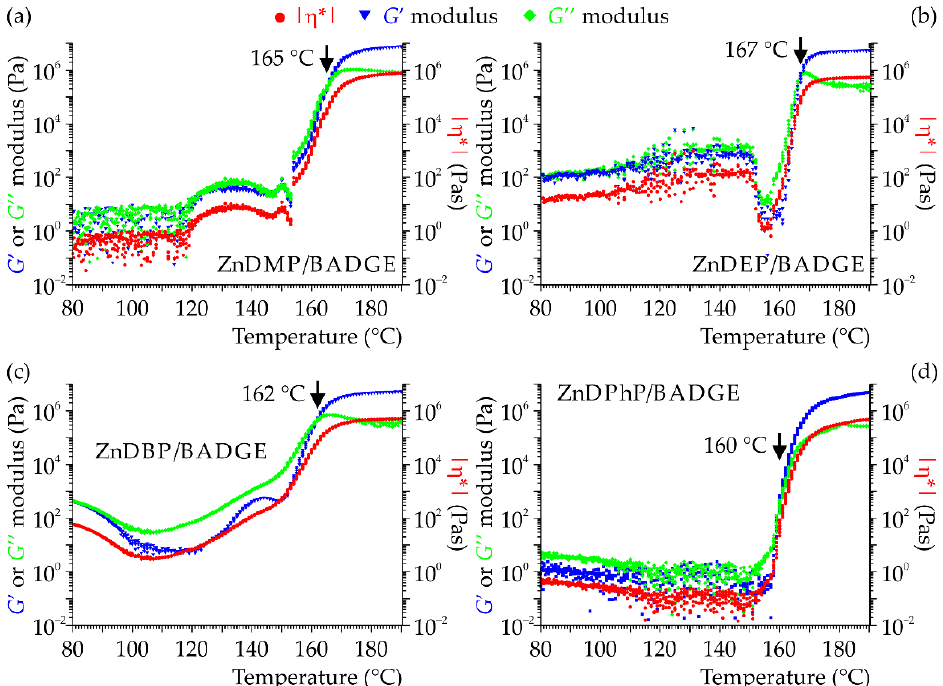
Figure 7. Variation of the complex viscosity (| η *|), storage modulus ( G ’) and loss modulus ( G ’’) with temperature during thermal curing of the ZnDOP/BADGE mixtures containing 20 wt%: ( a ) ZnDMP (ZnDMP/BADGE), ( b ) ZnDEP (ZnDEP/BADGE), ( c ) ZnDBP (ZnDBP/BADGE), or ( d ) ZnDPhP (ZnDPhP/BADGE). The lowest temperature at which G (cid:48) ≥ G (cid:48)(cid:48) is indicated with an